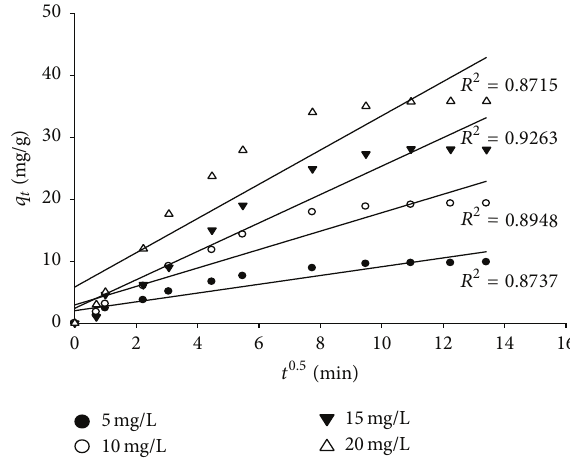
Figure 14: Intraparticle diffusion model (pH= 5.6, dose = 0.5 g/L, contact time = 180min, and temperature = 30 ∘